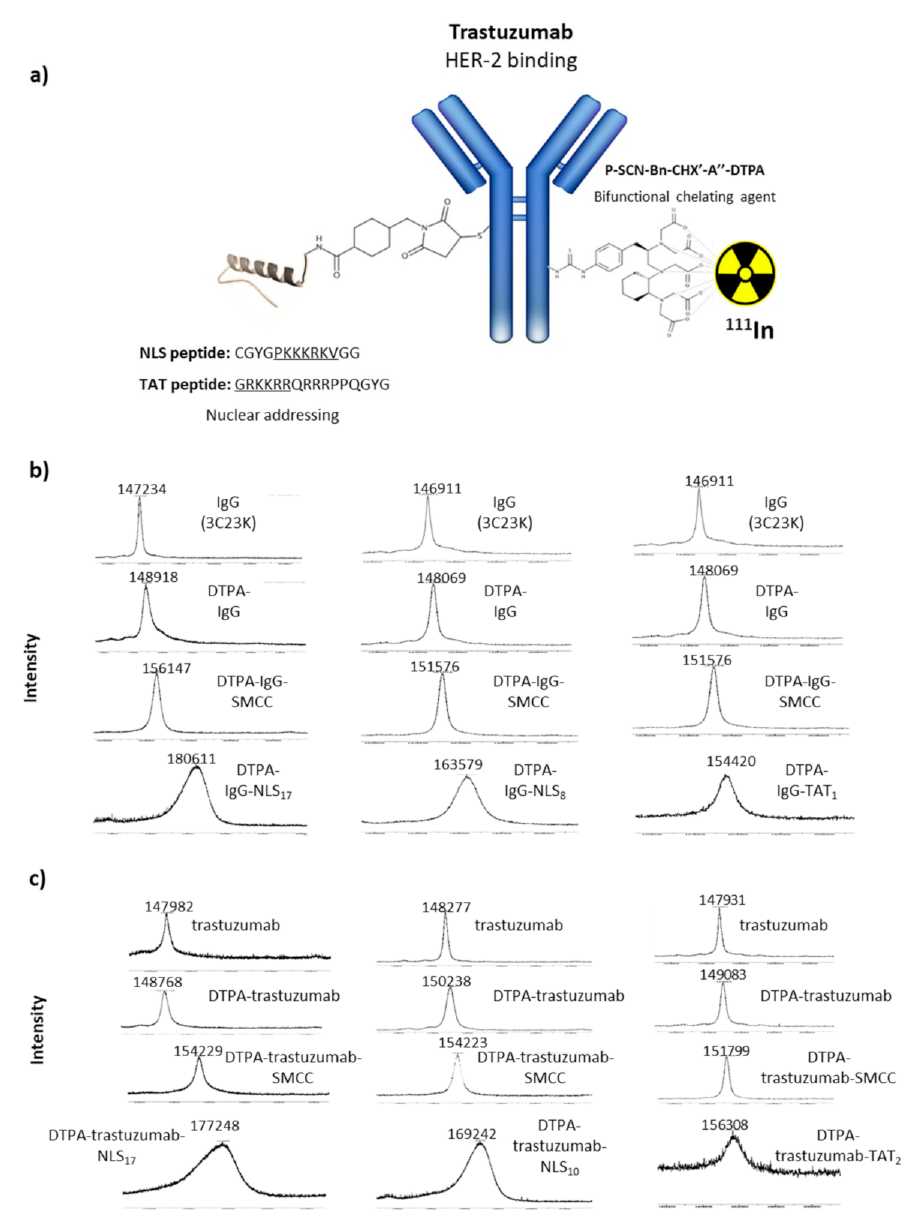
Figure 1. MALDI–TOF analysis of immunoconjugates. ( a ) Schematic representation of the DTPA- mAb-sulphoSMCC-TAT and DTPA-mAb-sulphoSMCC-NLS immunoconjugates. ( b ) MALDI–TOF analysis of IgG, DTPA-IgG, DTPA-IgG-sulpho-SMCC and DTPA-IgG-sulpho-SMCC-TAT, and DTPA- IgG-sulphoSMCC-NLS immunoconjugates. ( c ) MALDI–TOF analysis of trastuzumab, DTPA- trastuzumab, DTPA-trastuzumab-sulpho-SMCC and DTPA-trastuzumab-sulpho-SMCC-TAT, and DTPA-trastuzumab-sulphoSMCC-NLS